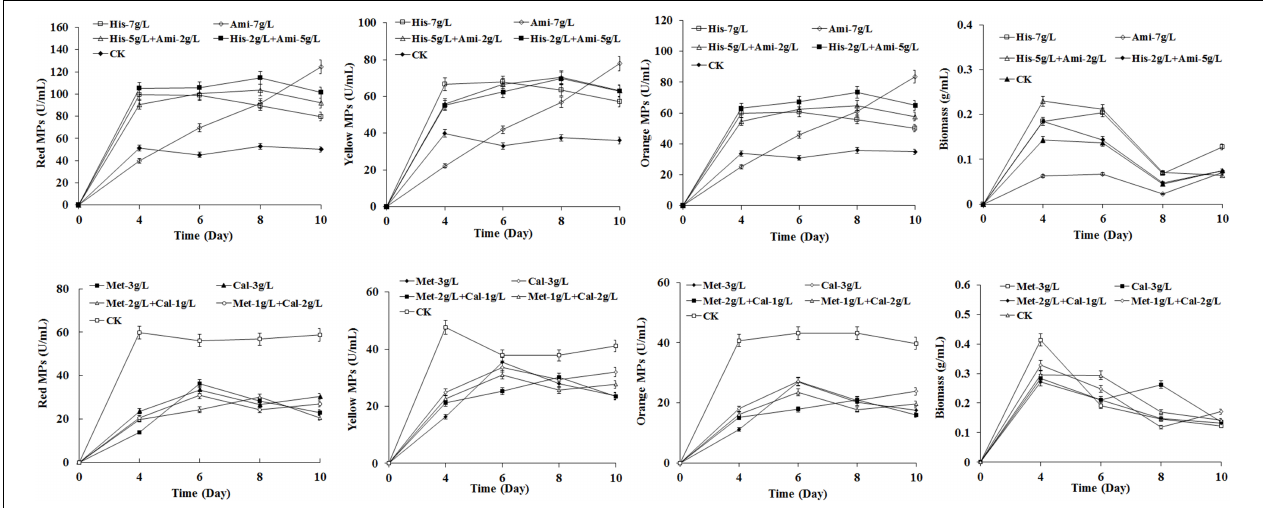
FIGURE 4 | Effects of analogs of HIS and MET on Monascus pigments (MPs) production in Monascus purpureus RP2 fermentation. CK, M. purpureus RP2 fermentation without the addition of amino acid; His, M. purpureus RP2 fermentation with the addition of HIS; Ami, M. purpureus RP2 fermentation with the addition of amitrole; Met, M. purpureus RP2 fermentation with the addition of MET; Cal, M. purpureus RP2 fermentation with the addition of calcium 2-hydroxy-4-(methylthio)